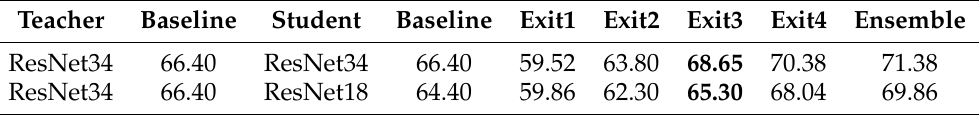
Table 3. Accuracies (%) obtained for the Tiny ImageNet dataset. The first early exit that exceeds the performance of the benchmark method is marked in bold